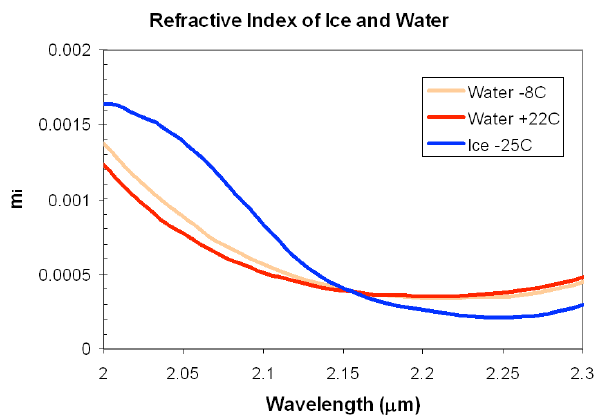
Fig. 8. Data extracted from Kou et al. (1993) shows the spectral dependence of the imaginary component of the refractive indices of ice and water between 2.0 and 2.3µm, showing the crossing point around 2.15µm. The water case also shows some dependence with temperature.